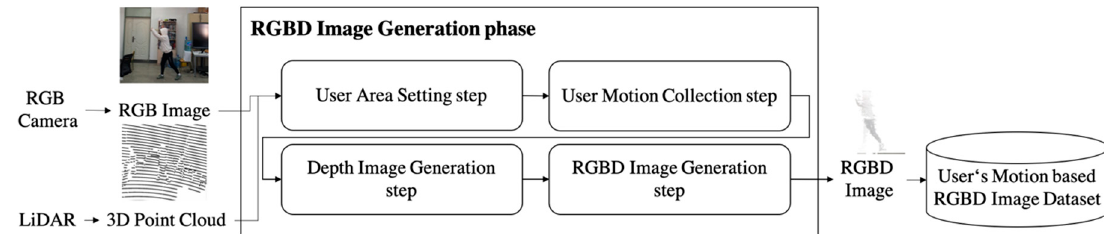
Figure 2. Process for generating RGBD image.